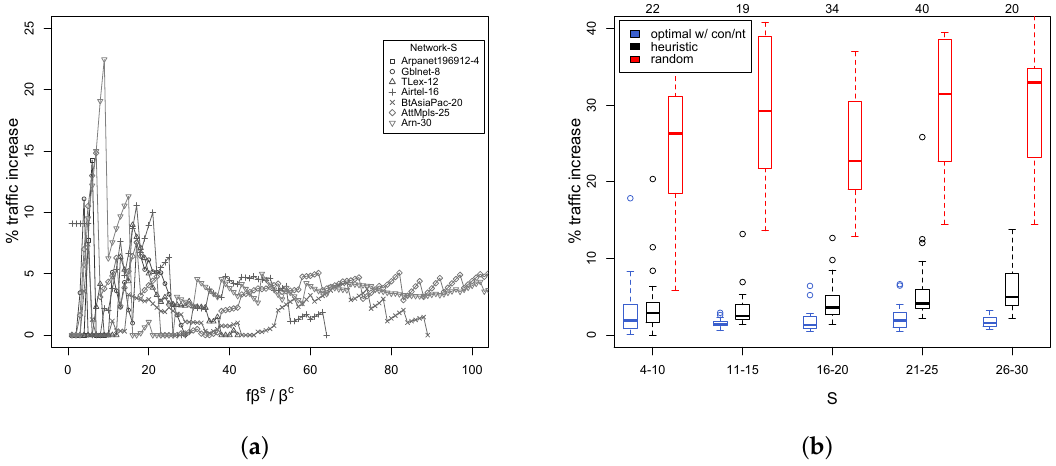
Figure 4. Percentage of control traffic ( B S + B C ) increase when C h is used instead of C ∗ , for various networks in the Internet Topology Zoo collection. ( a ) Percentage of control traffic increase for various f β s / β c in 7 example topologies. Topology names are suffixed by their size S . ( b ) Percentage of control traffic increase for several solutions, with respect to the optimum, averaged over all f β s / β c values, for various networks of size S ≤ 30. Top axis gives the number of network topology samples for each group of S